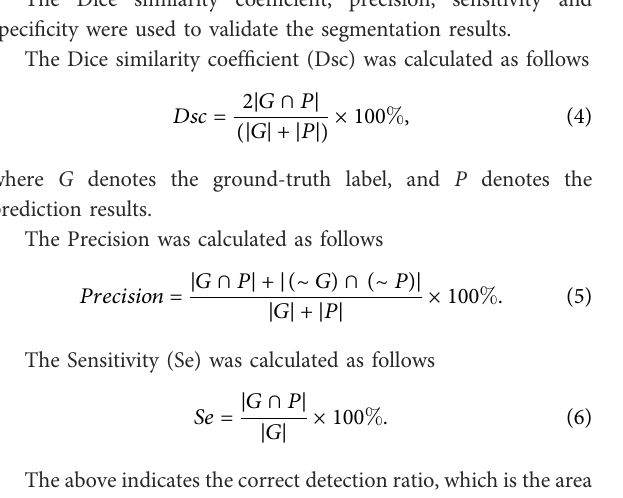
TABLE 2 Results of segmentation of the right and left lung parenchyma. Left Right